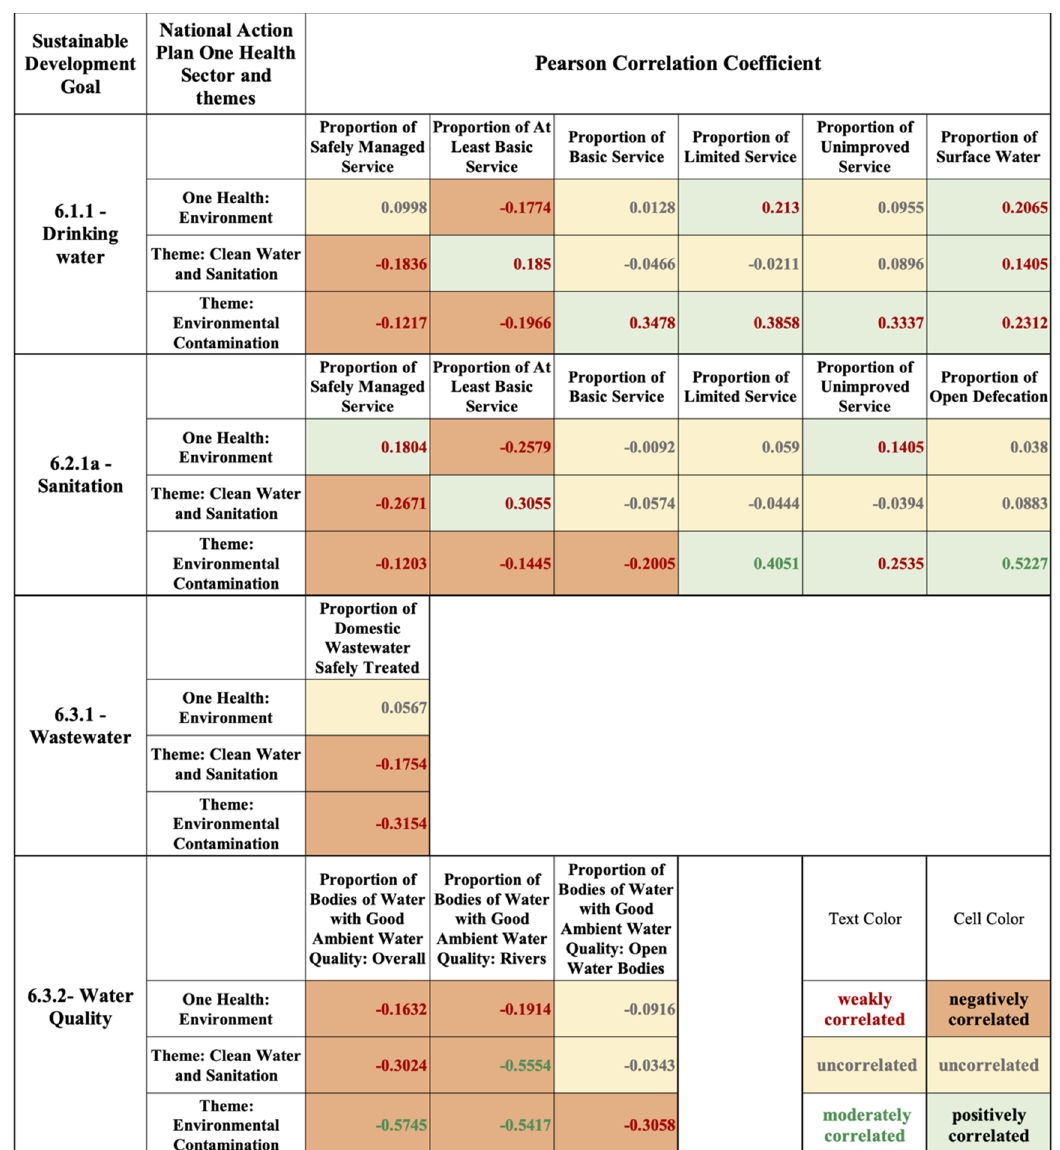
Figure 9. SDG 6 indicators and NAP case study evaluation scores (environment One Health sector, clean water and sanitation theme, environmental contamination theme) Pearson correlation analysis results.